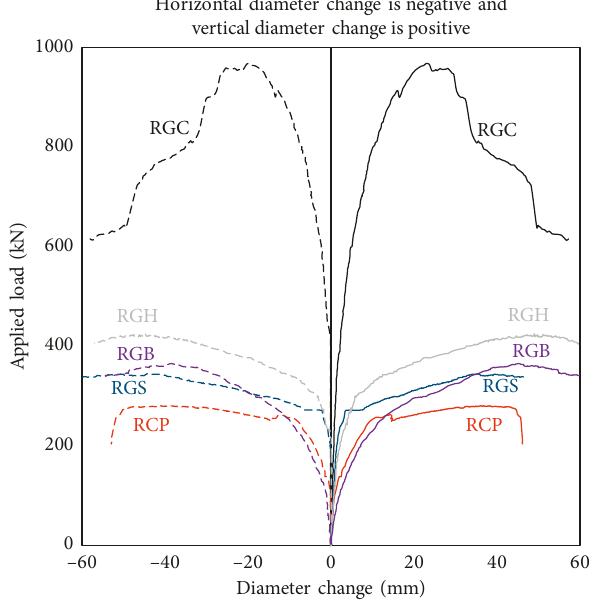
Figure 3: Applied load versus diameter diameter change of the RCP (48.1 mm versus 37.61 mm); the RGB had approximately 1.31 times the load-carrying capacity of the RCP (366 kN versus 280 kN), 1.27 times the vertical diameter change of the RCP (45.1 mm versus 35.425 mm), and 1.02 times the horizontal diameter change of the RCP (38.3 mm versus 37.61 mm).